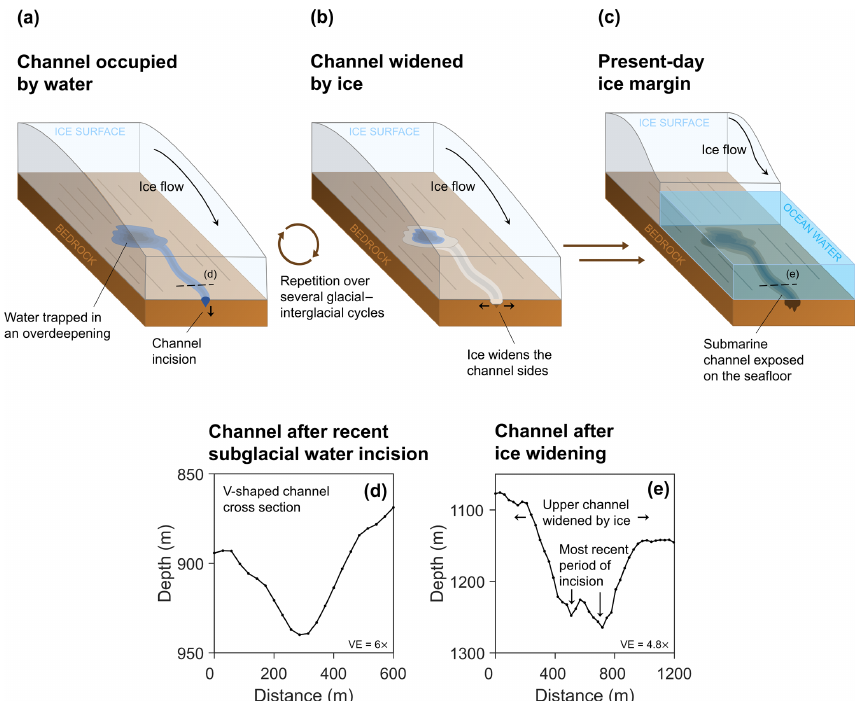
Figure 8. Schematic of channel formation over multiple glacial–interglacial cycles. (a) Channels are incised by short-lived episodes of fast- flowing subglacial meltwater, potentially released from lakes trapped in overdeepenings during ice-sheet advance and retreat. (b) Repeated periods of ice overriding widens the top of the channels. (c) A composite channel feature, produced over multiple glaciations, is left exposed on the seafloor. (d) Example of a more recently incised channel, characterized by a V-shaped cross section. (e) Cross section of a channel persisting from previous glacial periods containing both V-shaped meltwater signatures and a wide upper channel section eroded by ice. Vertical exaggeration (VE) is 6 × in (d) and 4 . 8 × in (e)